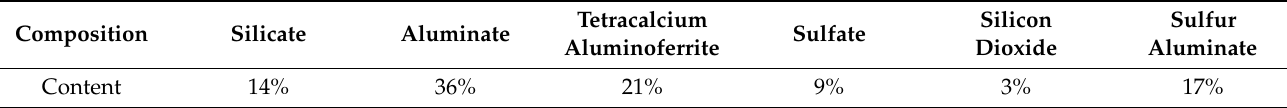
Table 2. Curing agent chemical makeup [37].